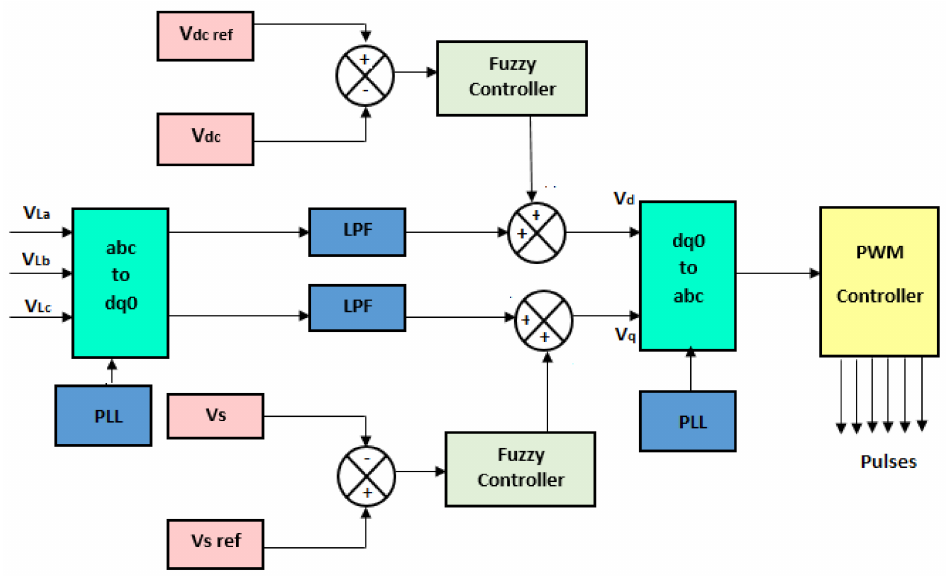
Figure 11. Control block diagram of